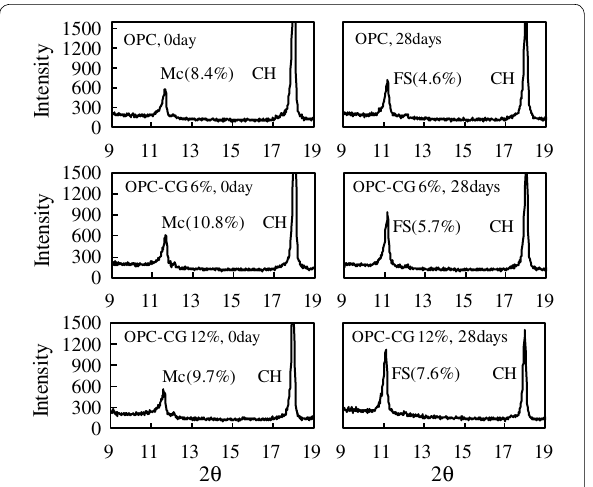
Fig. 10 XRD chart of cement paste. Fig. 11 Relation between Al